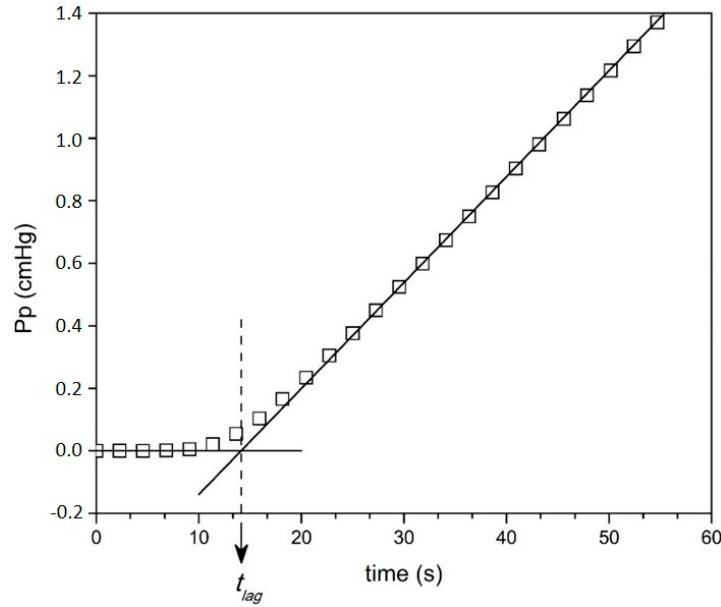
Figure 7. Permeate pressure vs. time for the PU10 membrane for CO 2 at feed pressure of 269 cmHg ( Pf ). Vertical dashed line intercepts the x ( Pp = 0) axis at the time lag value ( t lag ). Table 3. Time lag ( tlag ) values, diffusion coefficients ( D ), and solubility coefficients ( S ) obtained from Table 2. O 2 and CO 2 permeation curves for the PU0, PU5, PU10, and PU15 nonporous symmetric membranes.